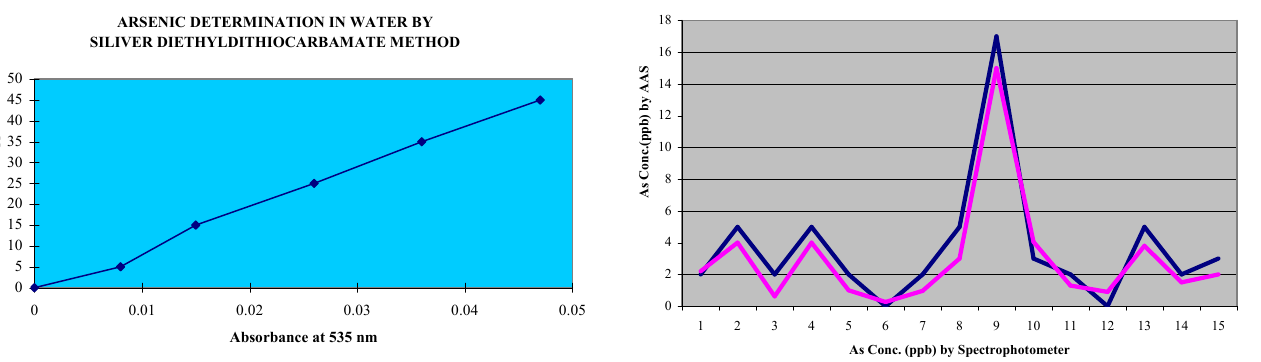
Figure 6. Absorbance vs. concentration without straight line. Figure-6: Absorbance Vs. Concentration without Straight Line